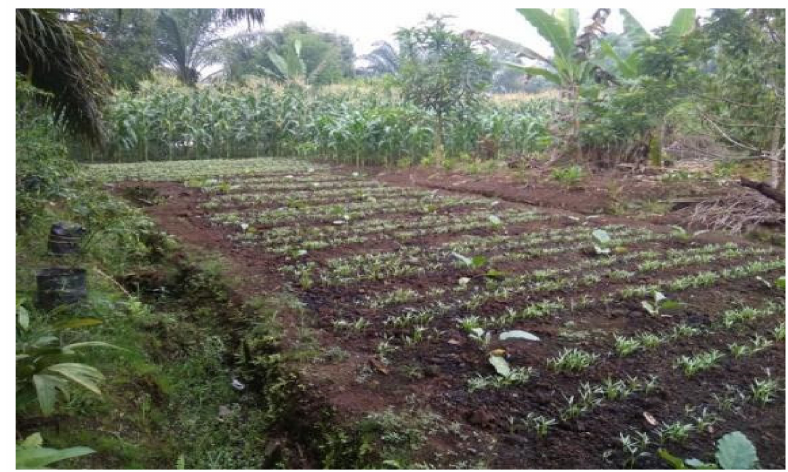
Figure 7. Raised bed (Surjan) technology.